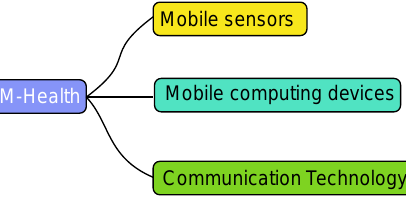
Figure 11. The different aspects of